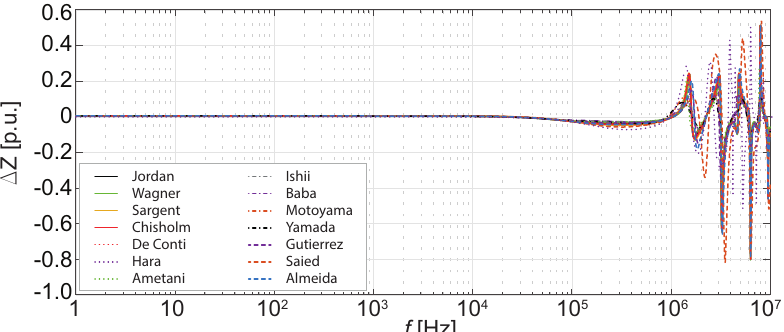
Figure 30. Difference ∆ Z in the absolute values of Z in computed considering the grounding system modeled by Z gr ( f ) or R gr , normalized to the former Z in with Z gr ( f ) for tower (b) case (soil resistivity ρ g = 600 Ω